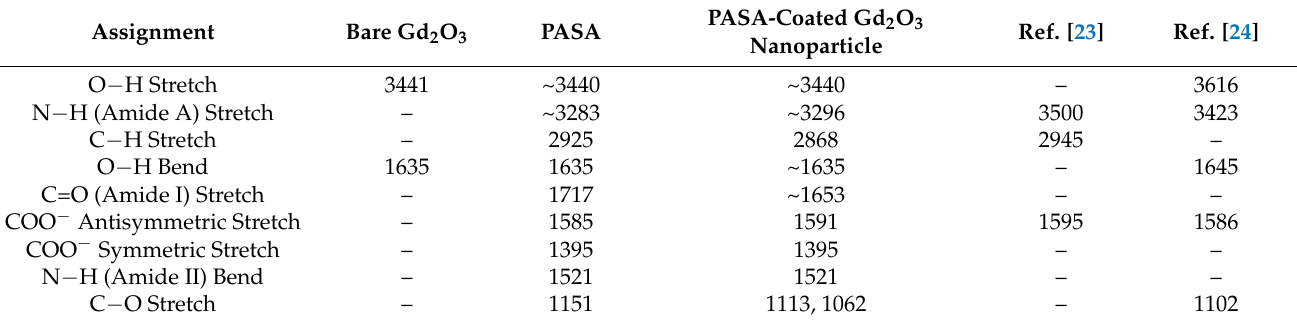
Table 2. Observed FT-IR absorption frequencies in cm − 1 .